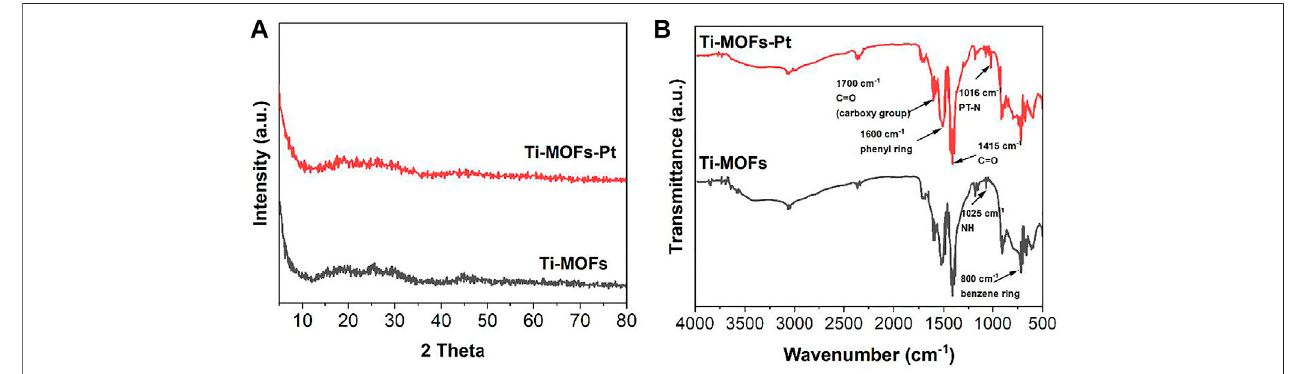
FIGURE 1 | (A) XRD patterns and (B) FTIR spectra of Ti-MOFs and